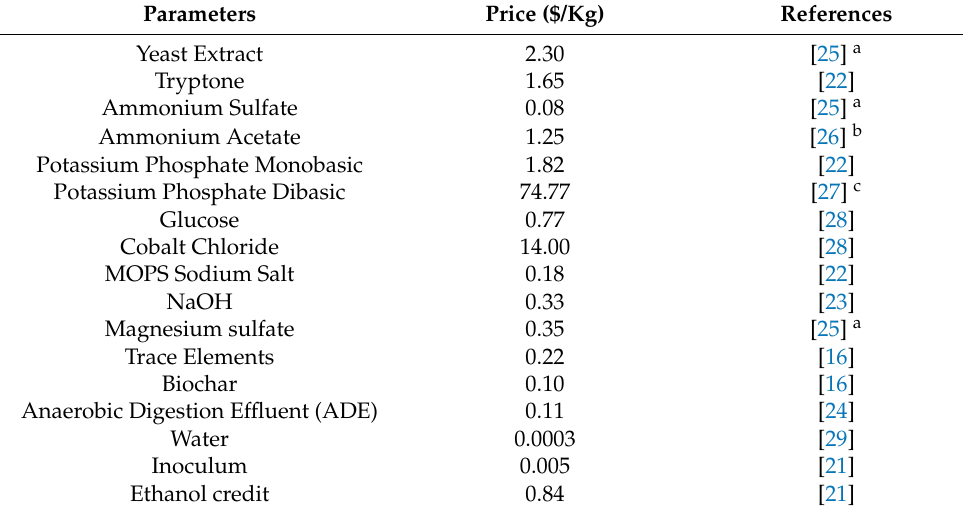
Table 3. Prices of raw materials, feedstocks, and consumables considered in the cost analysis of the 2,3-BD production